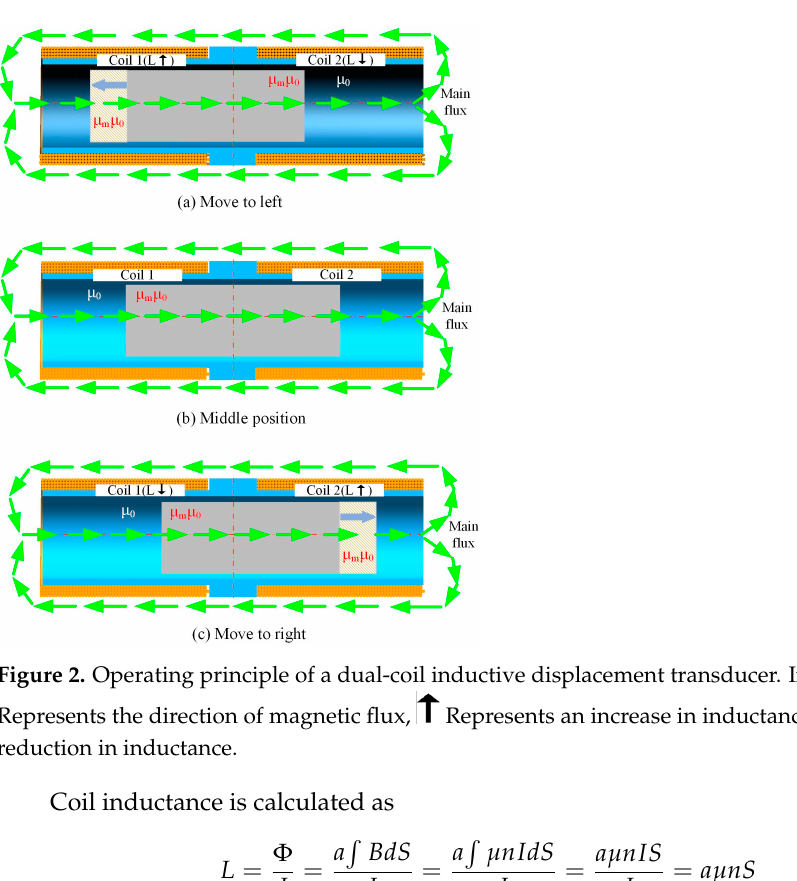
Figure 2. Operating principle of a dual-coil inductive displacement transducer. In the figure, Represents the direction of magnetic flux, Represents an increase in inductance, Represents a reduction in inductance. Coil inductance is calculated as